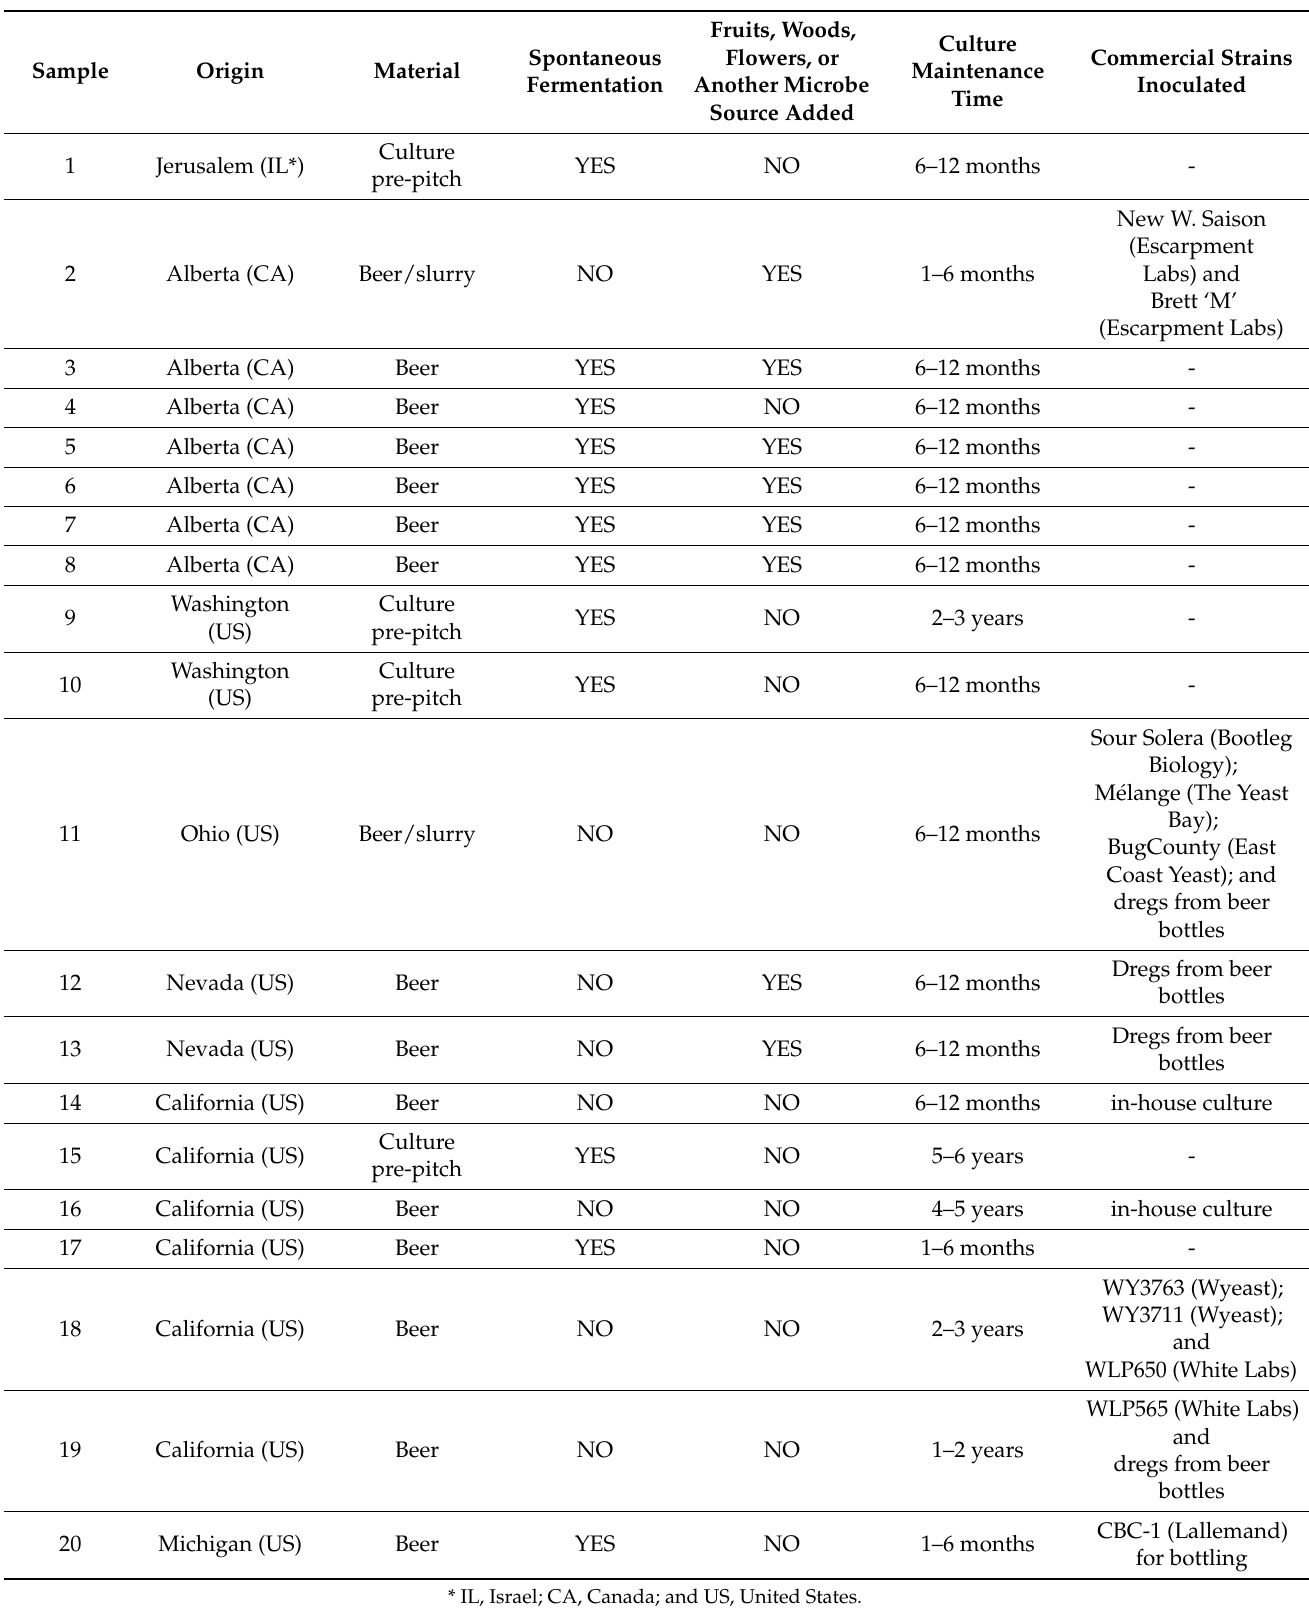
Table 1. Identification and characteristics of samples of the mixed cultures received for the